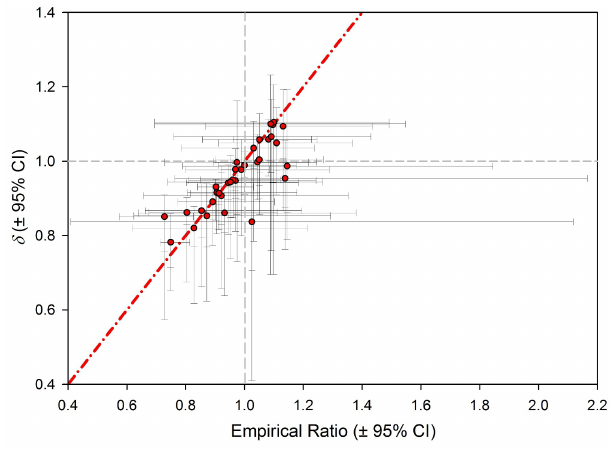
Fig. 3 . Comparison of Poisson generalized linear mixed model based (GLMM) estimates of δ (± 95% confidence intervals) against empirical estimates of δ (± 95% confidence intervals) calculated by dividing the mean ARU count by the mean human observer count in the withheld validation data. GLMM estimates were derived from iteratively (50 repeated random subsamples) fitting GLMMs to 70% of the study sites and compared against the empirical estimates of δ which were estimated from the 30% of withheld study sites. Dot-dash diagonal line (red) indicates 1:1 correspondence.